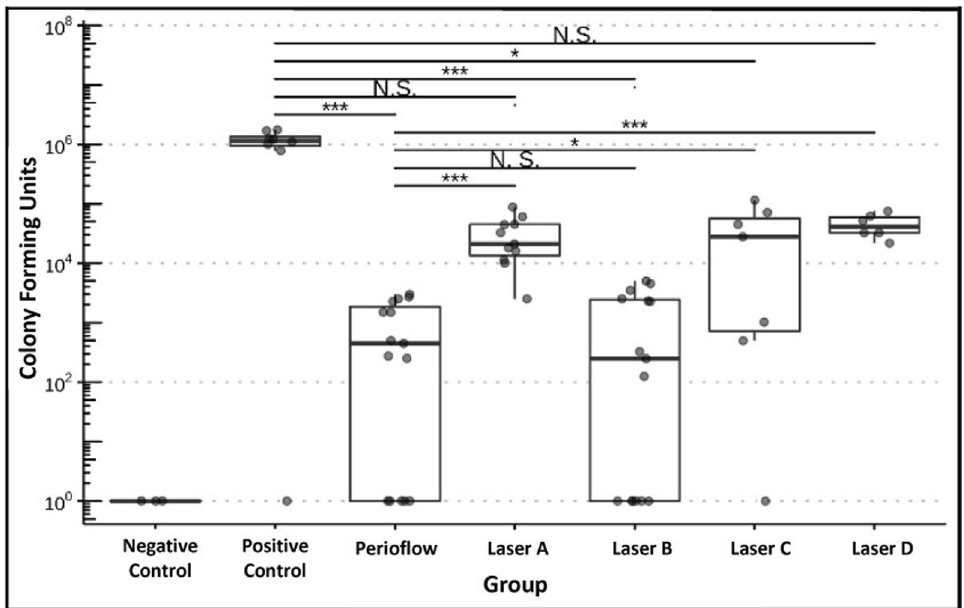
Fig. 6 Number of CFUs (representing viable Staphylococcus aureus cells) across all groups in the first test series. Dots represent single CFU measurements (3 times counted per disk). Dots plotted at 10 0 have an actual value of 0, not 1 (artificial